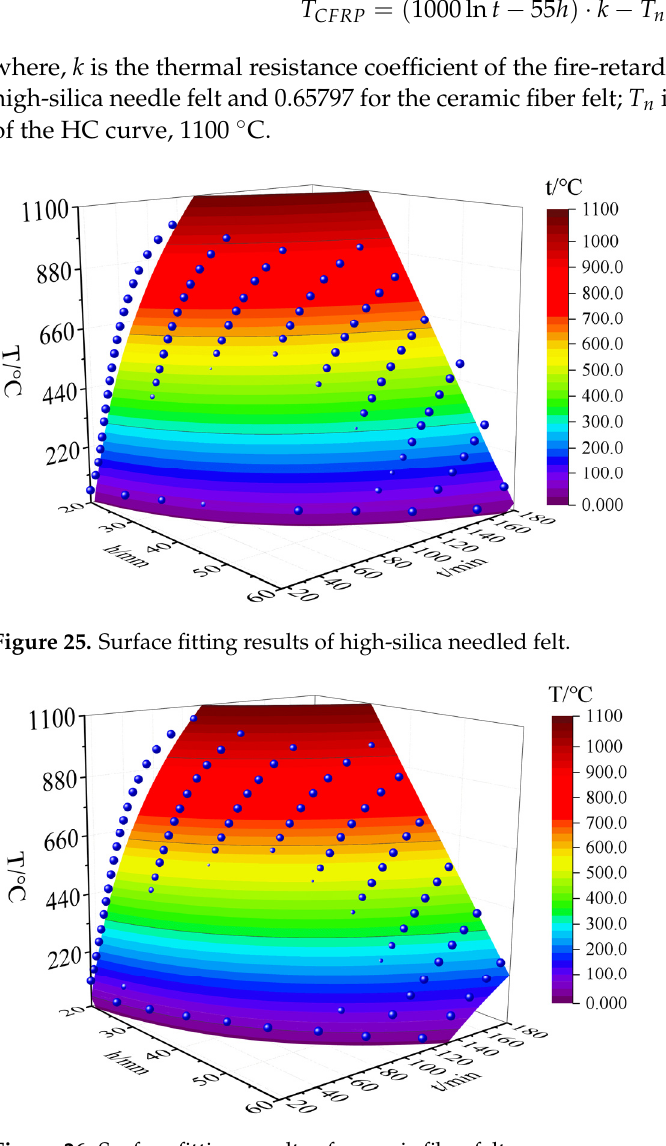
Figure 24. Variation of temperature along the thickness direction of fire ‐ retardant materials during heating for 2 h.